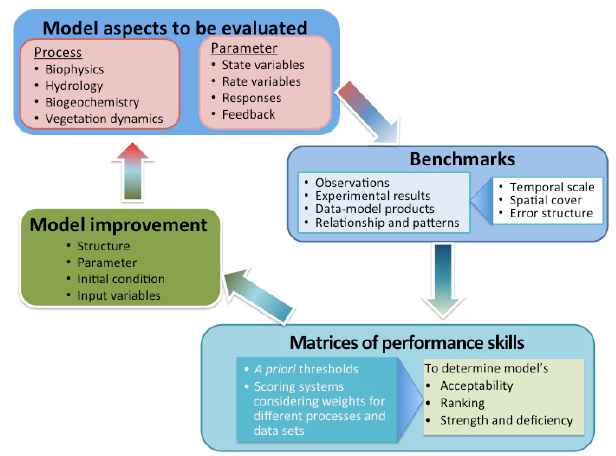
Fig. 1. Schematic diagram of the benchmarking framework for evaluating land models. The framework includes four major com- ponents: (1) defining model aspects to be evaluated, (2) selecting benchmarks as standardized references to test models, (3) devel- oping a scoring system to measure model performance skills, and (4) stimulating model